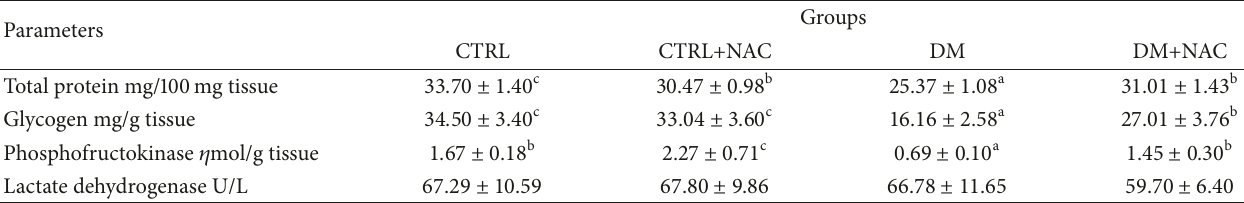
Table 2: Biochemical characteristics in diabetic rats that have been treated and not treated with